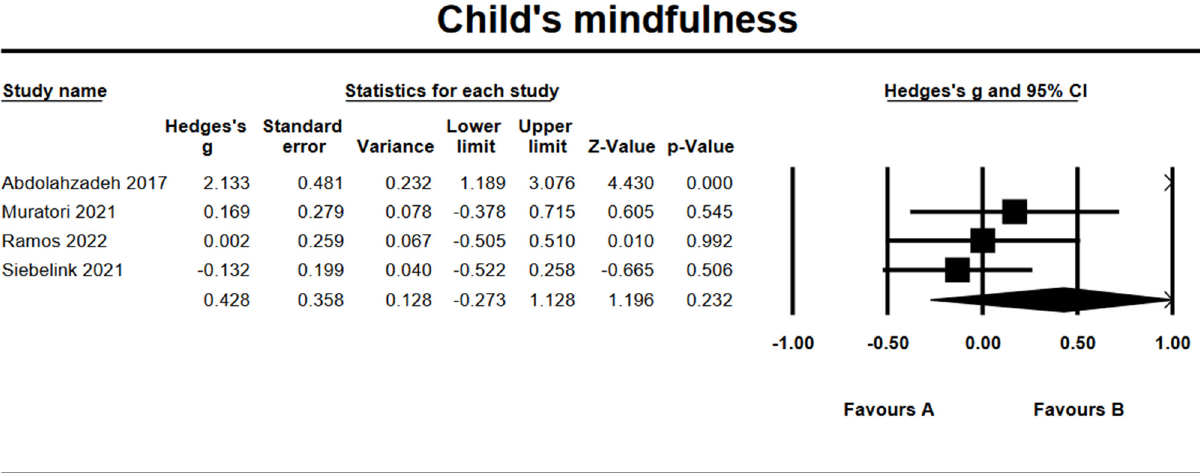
Figure 8. Forest plots of effect size for child’s mindfulness [28,32,35,39].